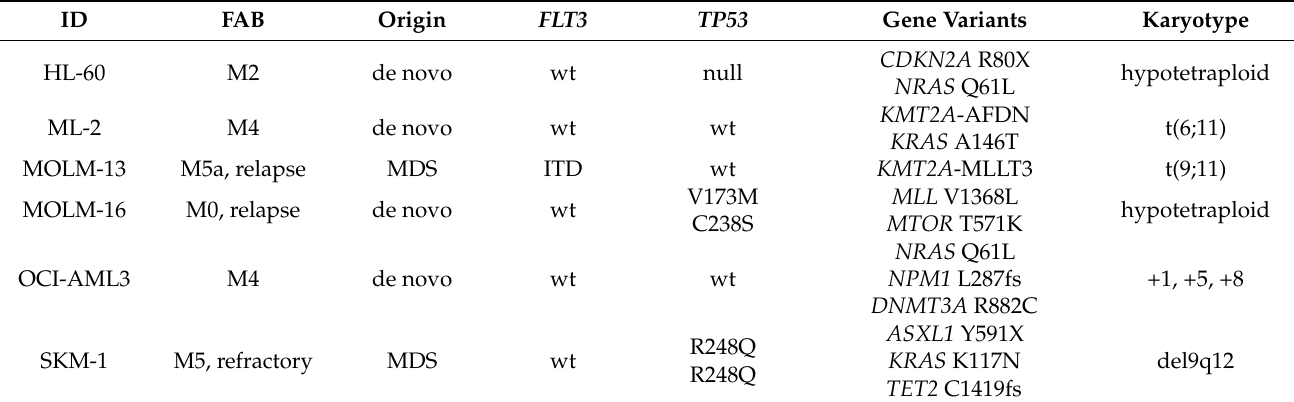
Table 1. Genetic variants in acute myeloid leukemia (AML) cell lines.